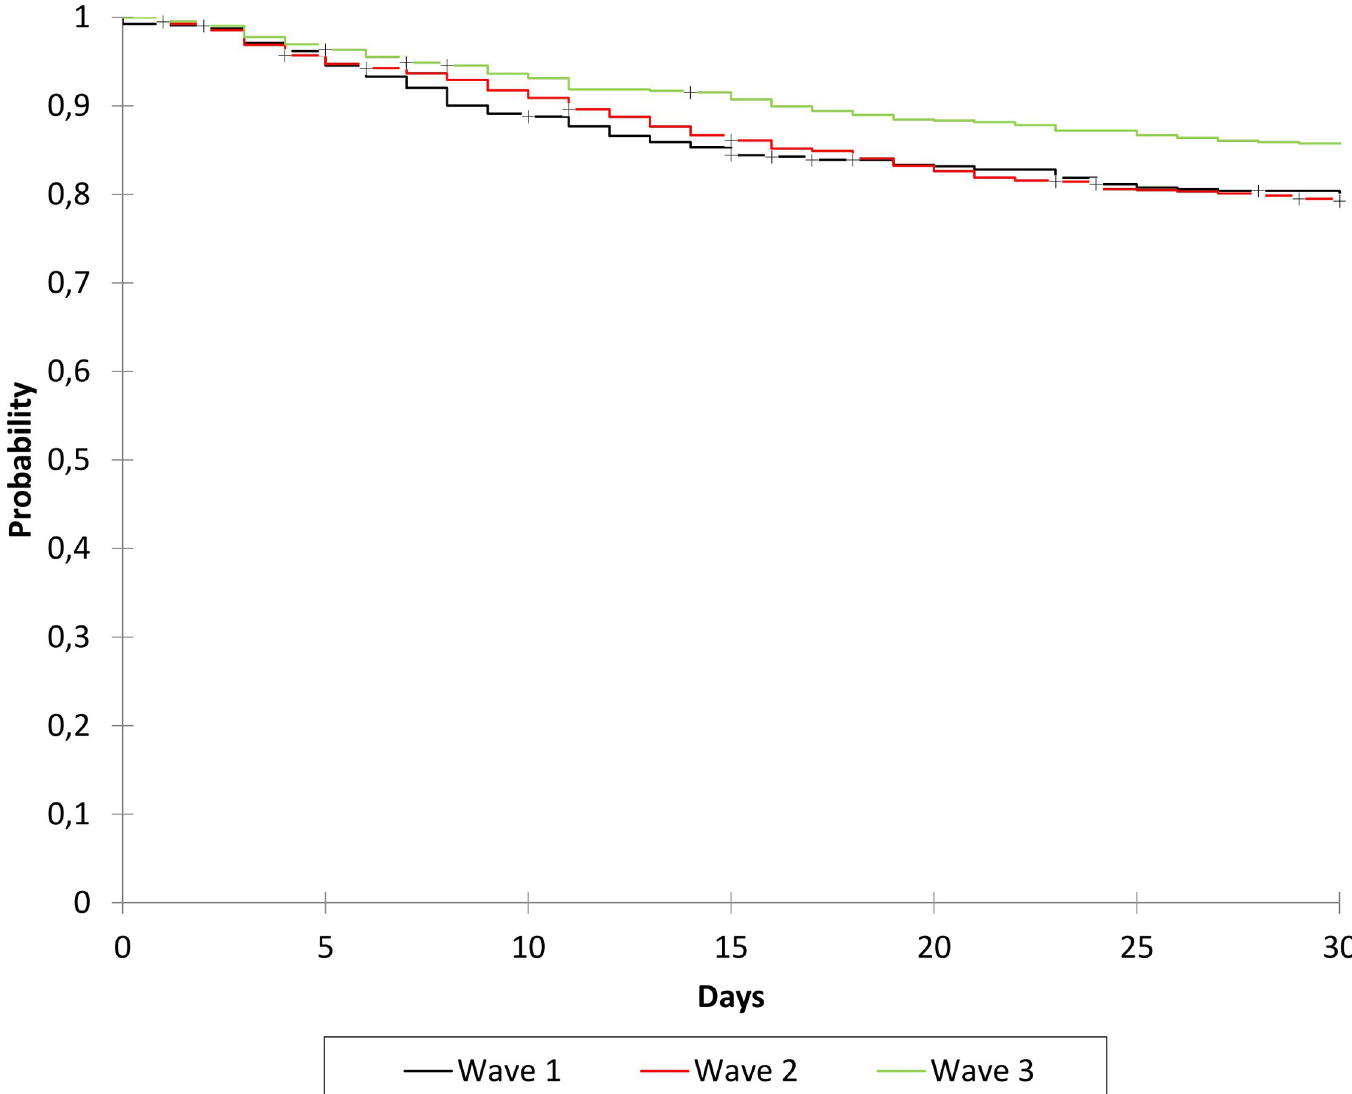
Fig 1. Time-dependent survival probability by period of hospital admission: Wave 1 (February-July 2020), wave 2 (August 2020-January 2021), and wave 3 (February-April 2021).